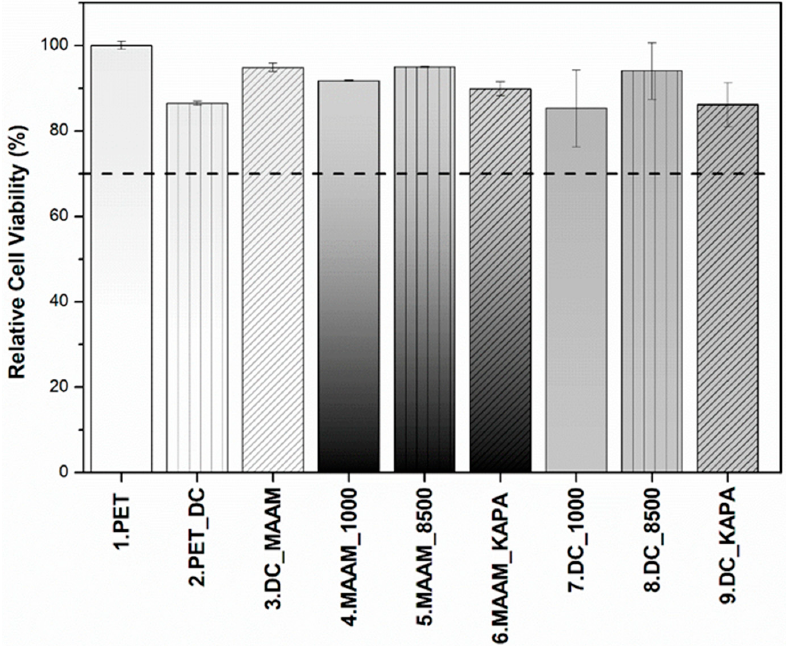
Figure 3. Relative cell viability of cells incubated with PET films coated with furcellaran of different water gel strengths (1000, 8500) and κ -carrageenan tested on a mouse embryonic fibroblast cell line (NIH/3T3).